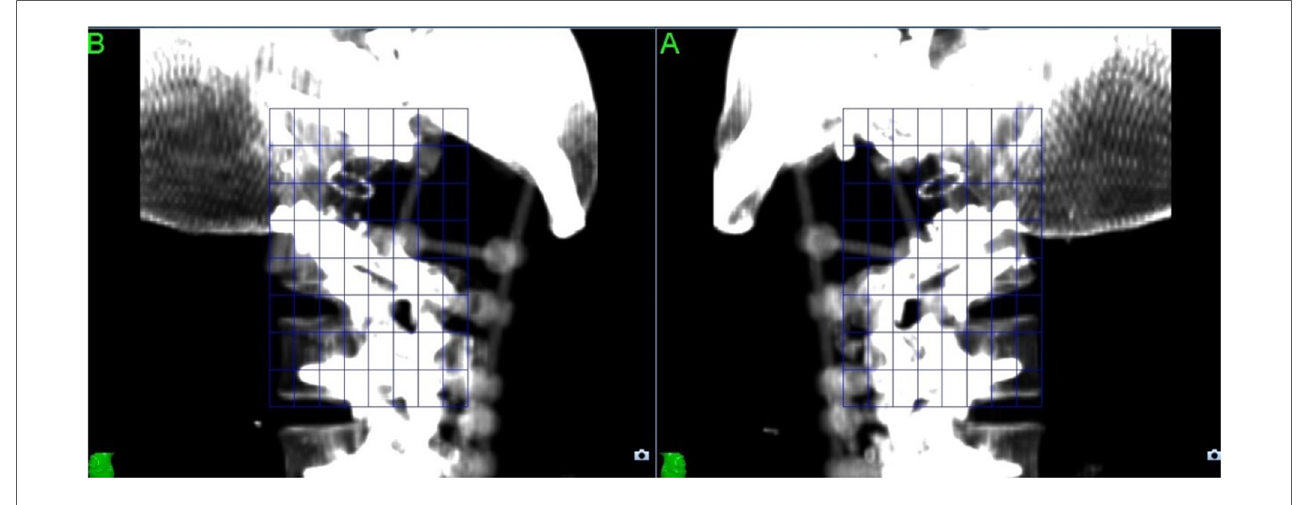
FIGURE 2 X-Sight Spine tracking DRRs from planning